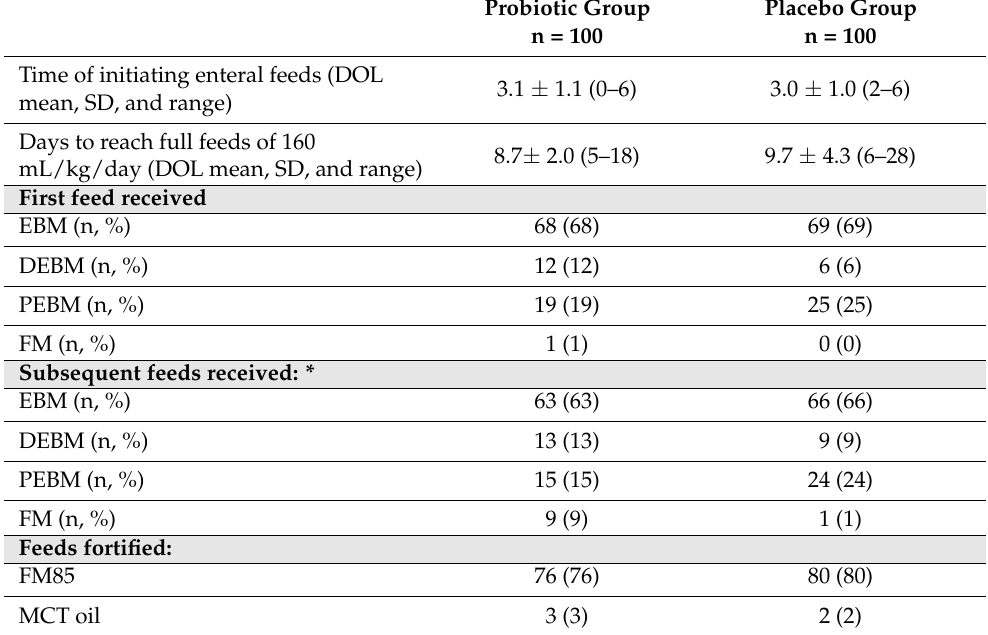
Table 2. Nutritional intake of the neonates enrolled in the study.